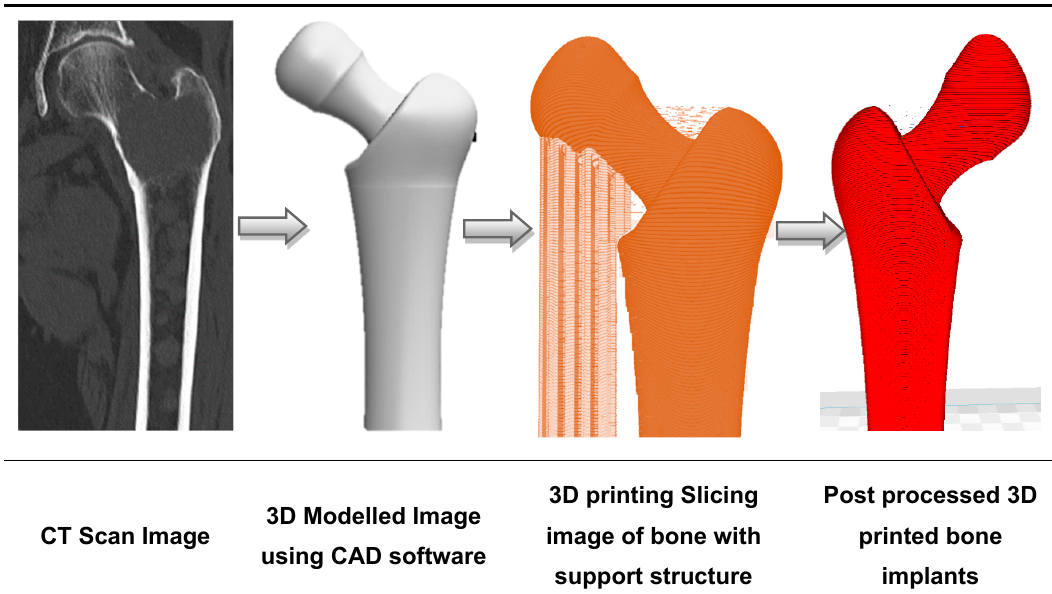
Figure 2. The sequence of bone implant fabrication using additive manufacturing.